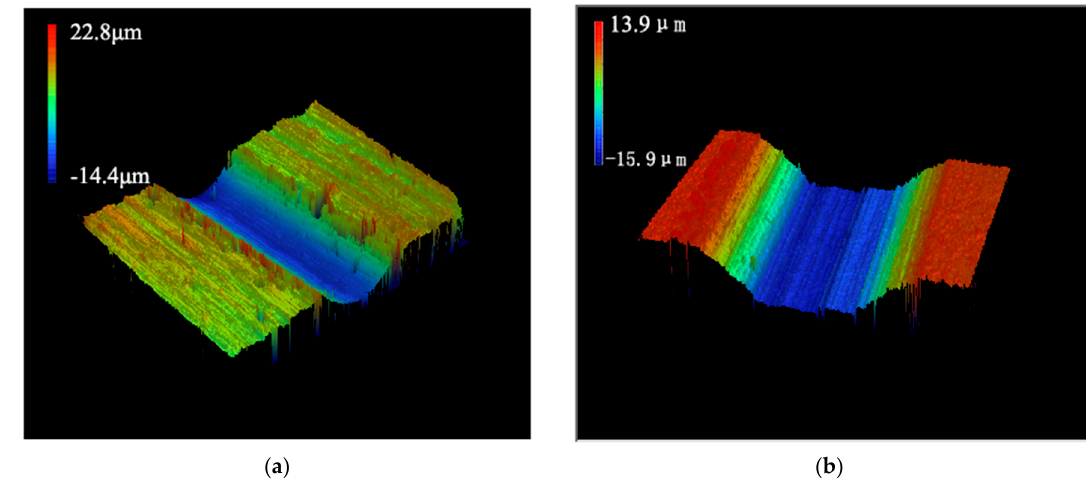
Figure 7. Microstructure of cladding layers at different laser powers: ( a ) 2# sample: 1.4 kW, 7 mm/s,